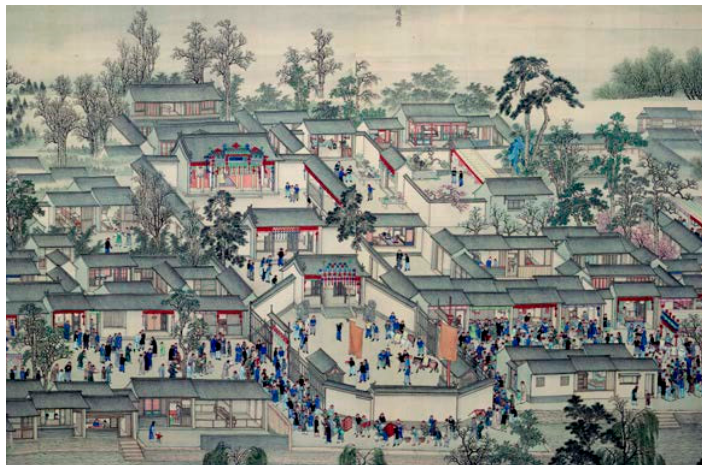
Figure 6. Wang Hui, Kangxi Emperor s Southern Inspection Tour, Scroll Seven, 1689